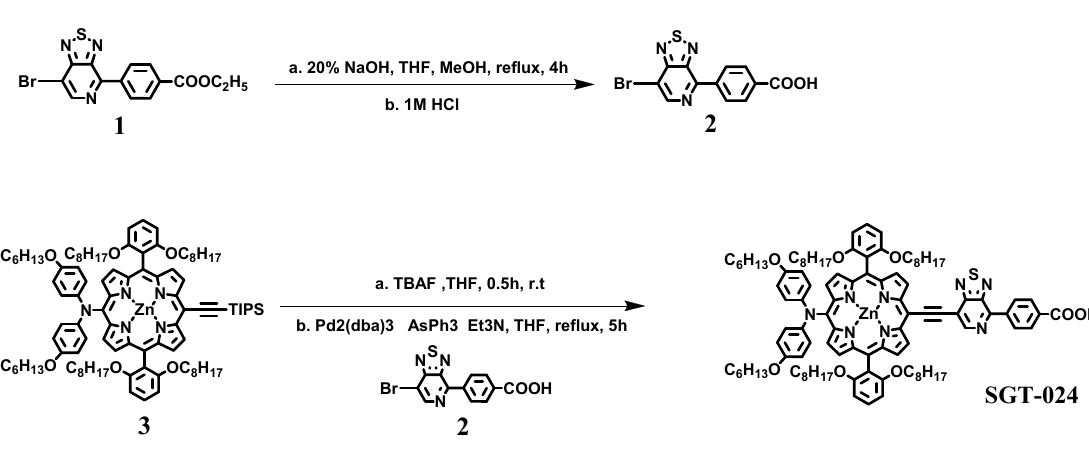
Figure 2. Energy-level diagram of SGT-020 and SGT-024 . Table 1. Photophysical and electrochemical data for SGT-020 and SGT-024 . Dye